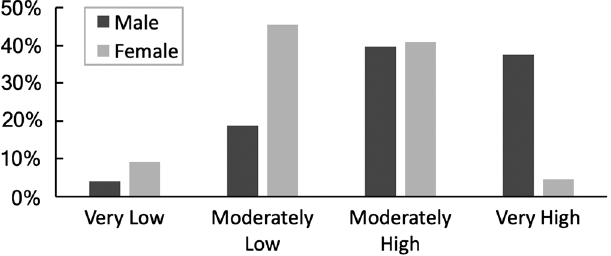
FIG. 2. Histogram of students ’ self-efficacy states in high school